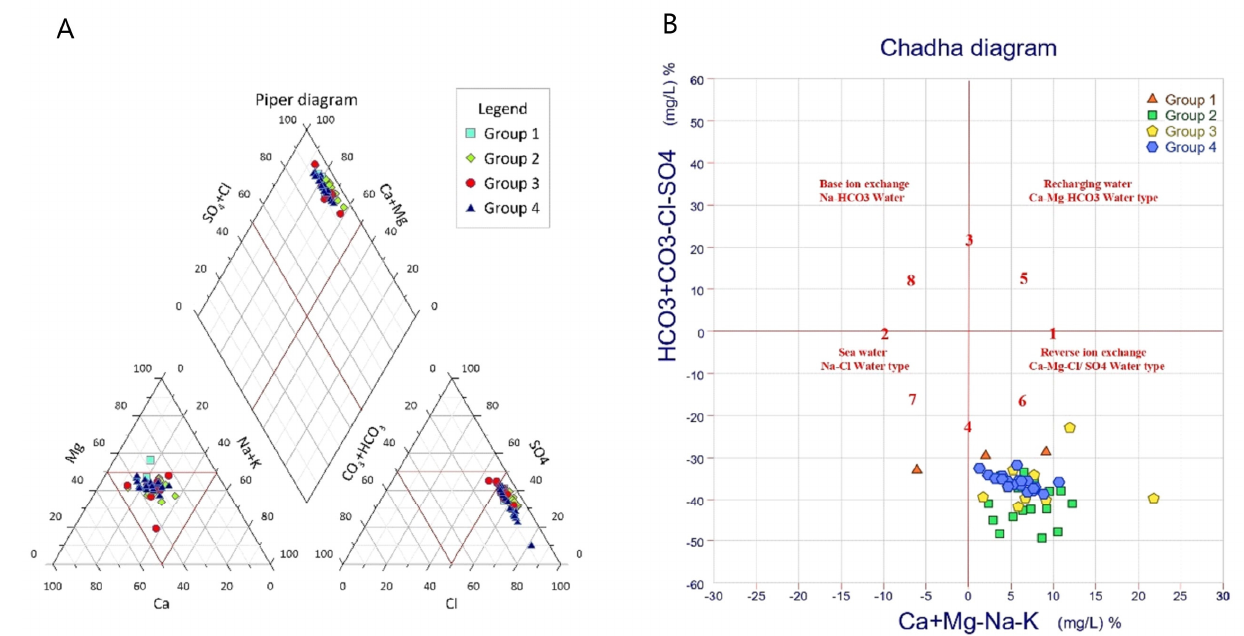
Figure 6. ( A ) Piper diagram for water samples, and ( B ) Chadha diagram of the groundwater samples.